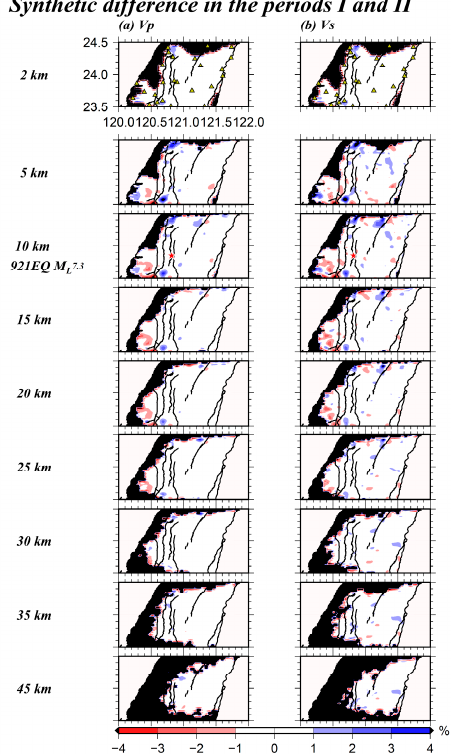
Figure 7. ( a ) A synthetic model with realistic configurations of anomalies. ( b ) Period III synthetic model of Vp. ( c ) Period III synthetic model of Vs. See the detail description in the text.